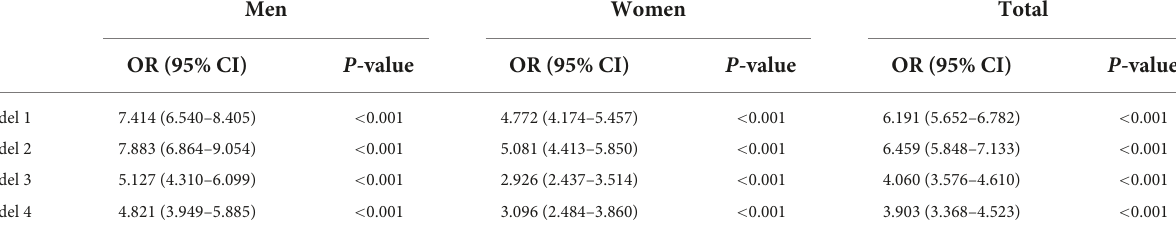
TABLE 2 The association of WHtR with MetS in T2DM patients.